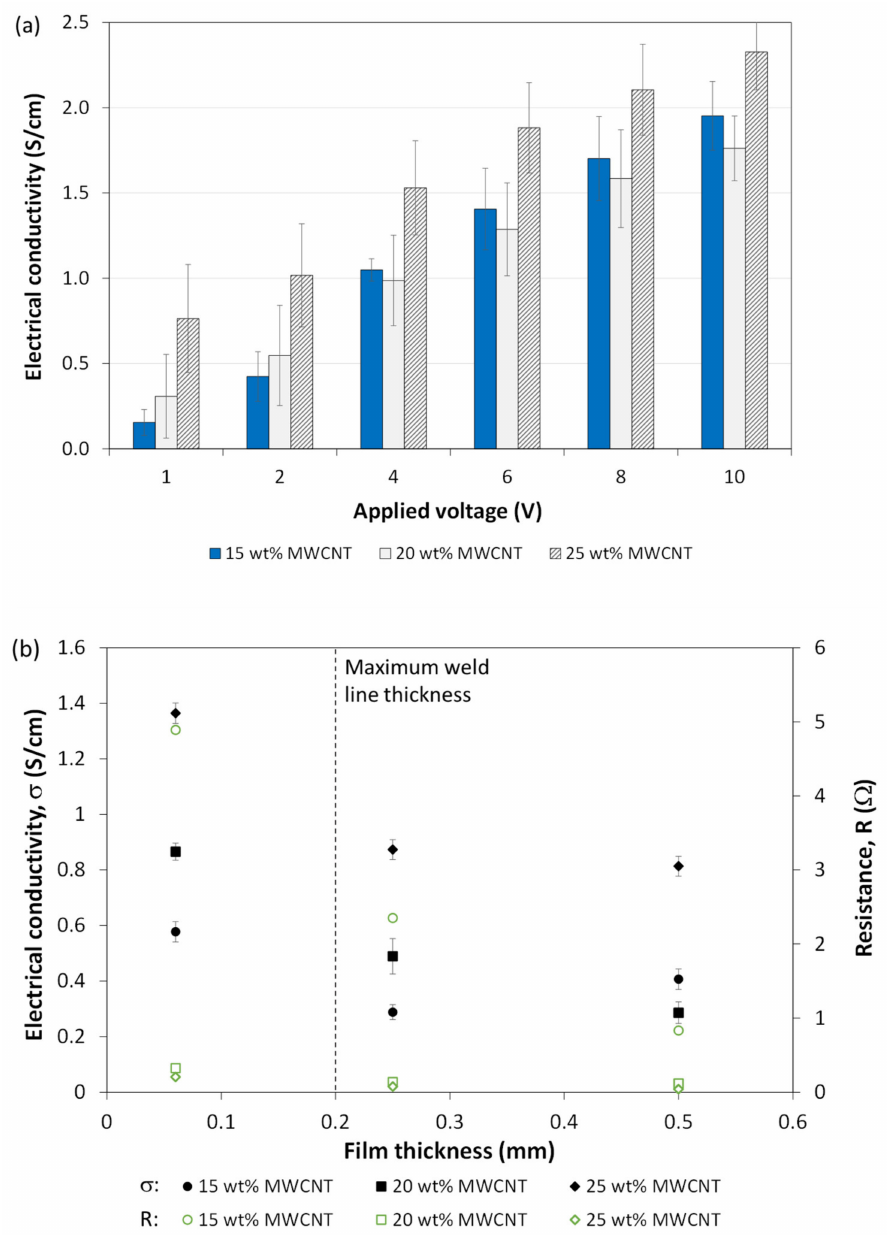
Figure 6. ( a ) Influence of applied voltage on average film electrical conductivity for 15 wt.%, 20 wt.% and 25 wt.% MWCNT; ( b ) influence of film thickness on electrical conductivity (filled markers) and resistance (unfilled markers) for 15 wt.%, 20 wt.% and 25 wt.% MWCNT. Representative data shown when voltage of 2 V was